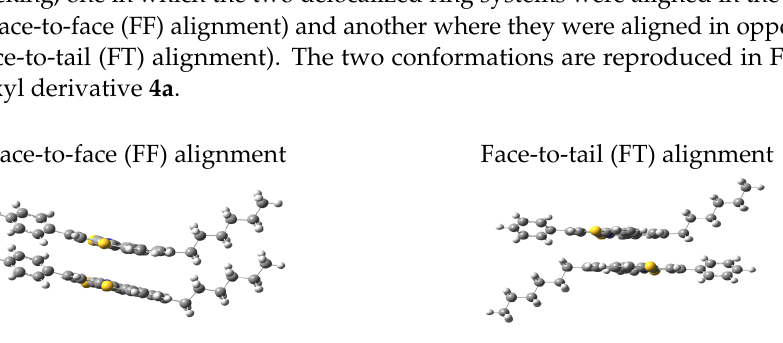
Figure 8. Face-to-face (FF) and face-to-tail (FT) alignments of dimers from cations of BPTDQ salt 4a . Table 5 lists some calculated properties of these dimers: the distance between their π-stacked planes, their dipole moments, the interaction energies between the two mono- mers, and their longest-wavelength λ max values.